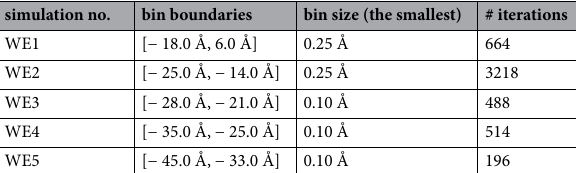
Table 1. A list of WE